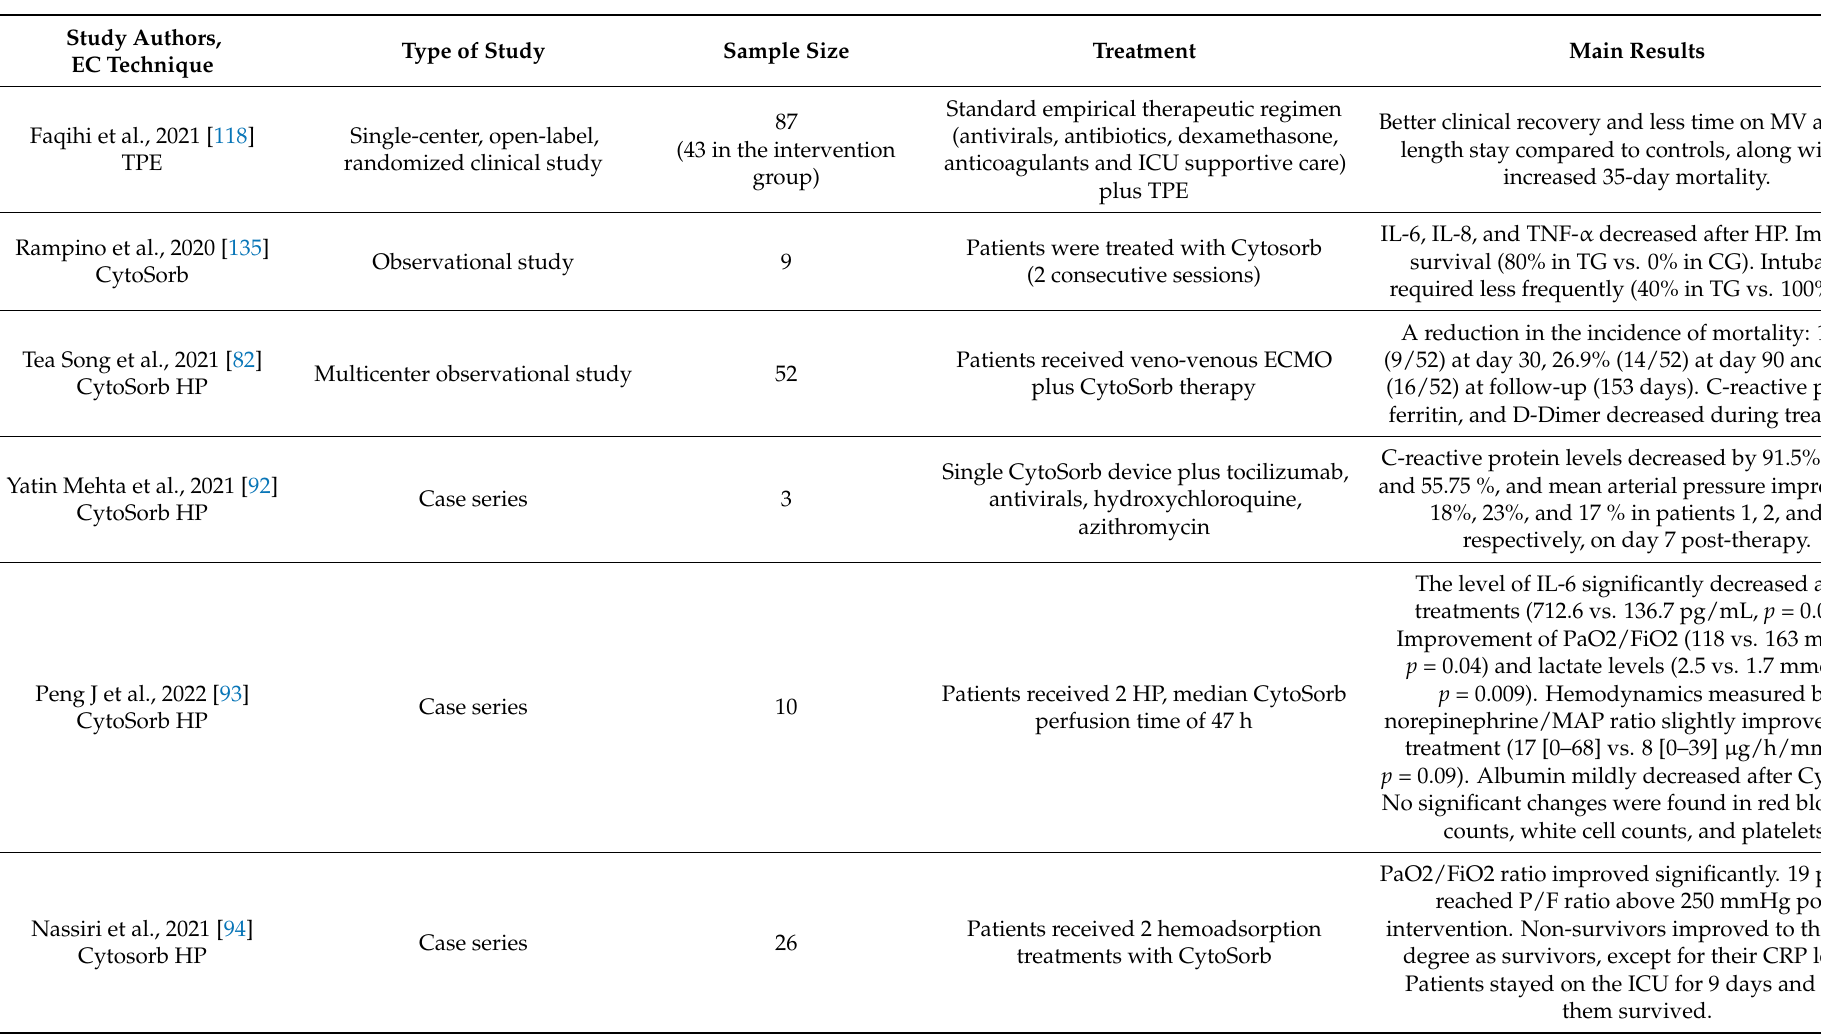
Table 1. Studies related to the use of TPE, CytoSorb, oXiris membrane and PMX-HP in COVID-19